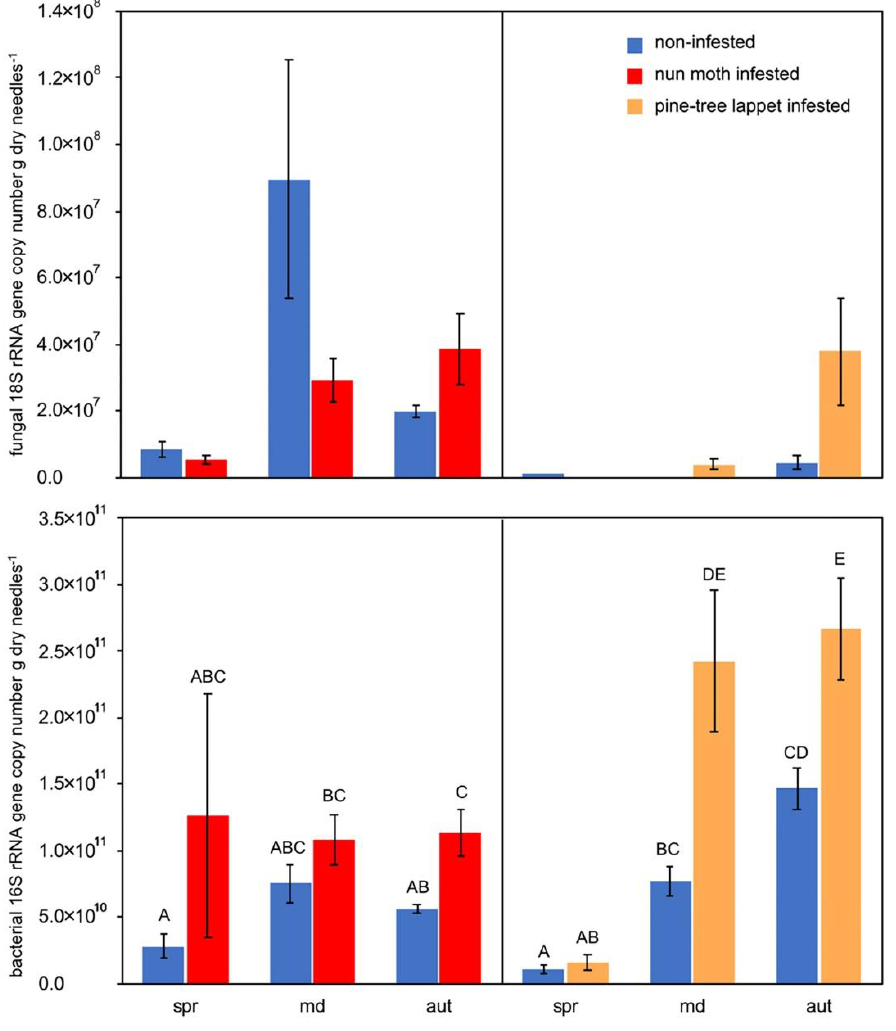
Figure 3. The mean fungal 18S rRNA and bacterial 16S rRNA gene copy numbers per gram of dry needles of the nun moth ( Lymantria monacha L.) and pine tree lappet ( Dendrolimus pini L.) infested and non-infested Scots pine ( Pinus sylvestris L.) forest site (the error bars represent standard error of the mean, spr = spring, md = main defoliation, aut = autumn. Varying sample sizes, see Table A6, different letters indicate statistically significant differences between the infested and non-infested needles based on the Kruskal-Wallis test with the subsequent Dunn’s test, p < 0.050). For fungal 18S rRNA, no statistical differences were found between the infested and non-infested needles.